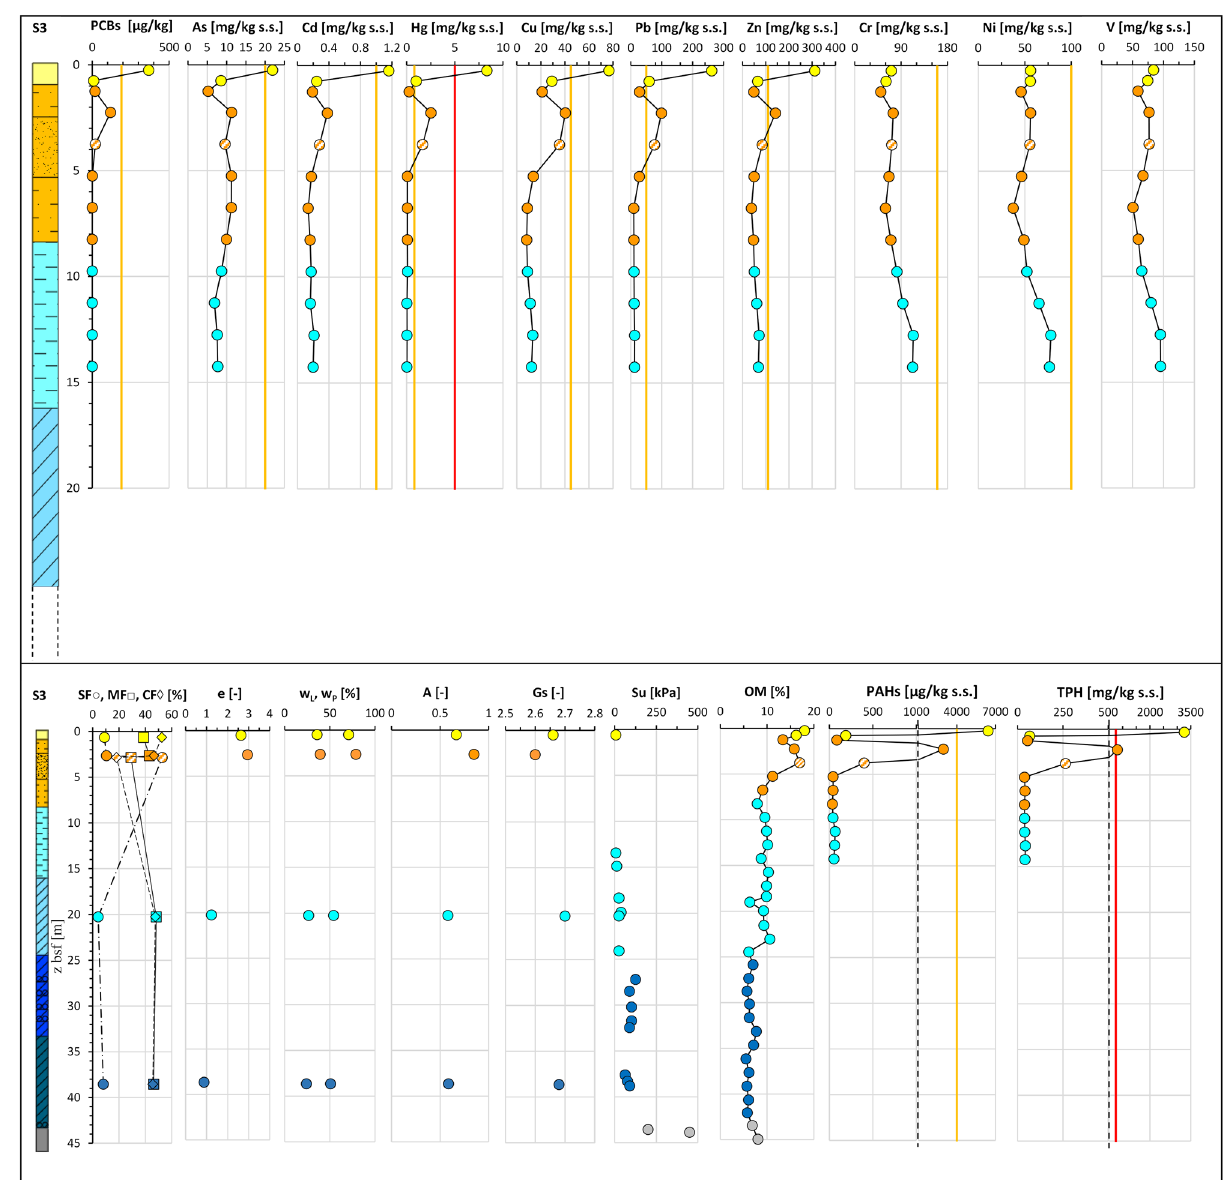
Figure 17. Vertical profiles of chemical and geotechnical properties along the S3 borehole in the I Bay of the Mar Piccolo